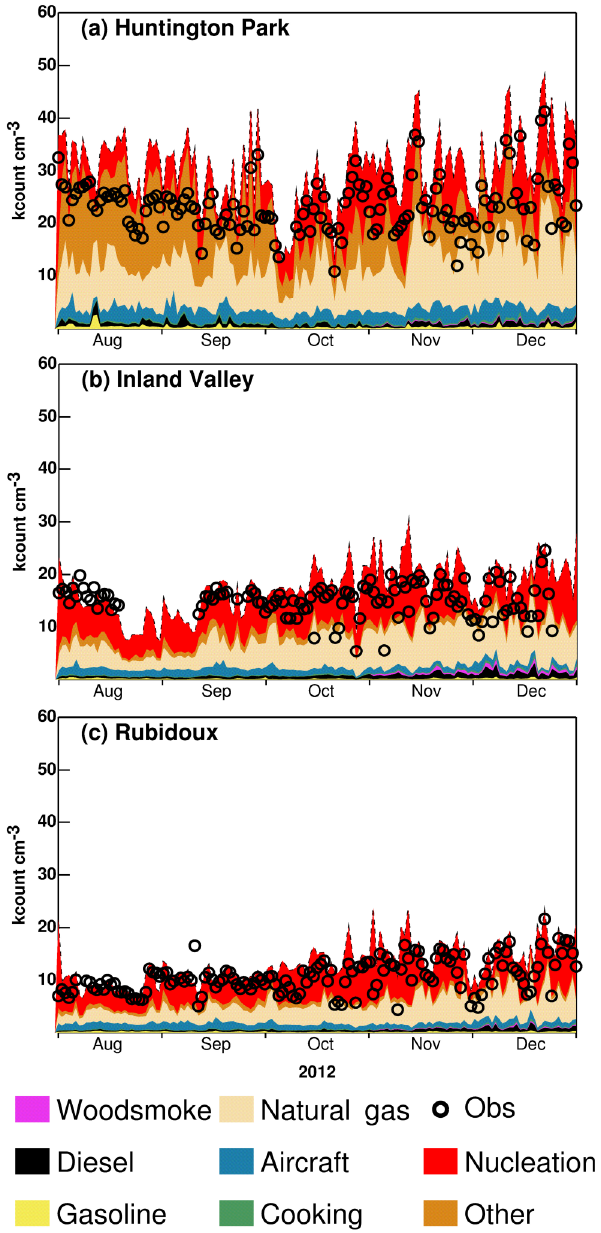
Figure 9. Seasonal variation of measured N 7 (black circles) and major source contributions to best-fit N 10 at Huntington, Inland Valley, and Rubidoux, respectively. Results within each month have daily time resolution.